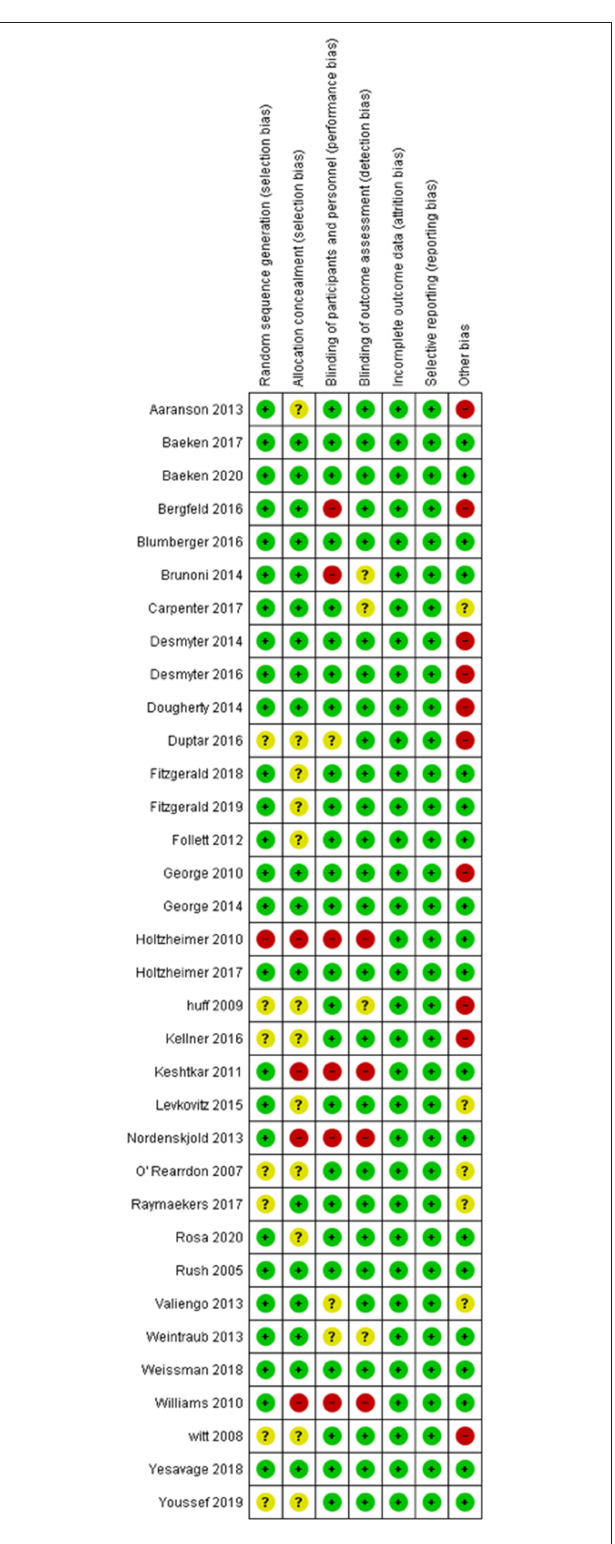
FIGURE 2 | Summary Table for the Risk of Bias in included studies. Randomized controlled studies that are included in our study were assessed by the risk of bias tool by Cochrane Collaboration. This tool allows readers to